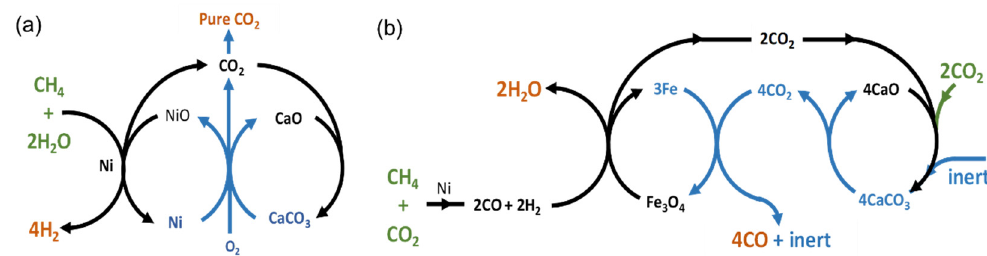
Figure 13. Schemes of combined chemical looping processes: ( a ) Sorption-enhanced chemical looping reforming of CH 4 , black arrows: NiO reduction, H 2 production by CH 4 reforming and water gas shift over Ni catalyst, carbonation, blue arrows: Ni oxidation, decarbonation. ( b ) Super-dry chemical looping reforming of CH 4 , black arrows: CO 2 reforming over Ni catalyst, FeO x reduction, carbonation, blue arrows: decarbonation, CO production by Fe oxidation.